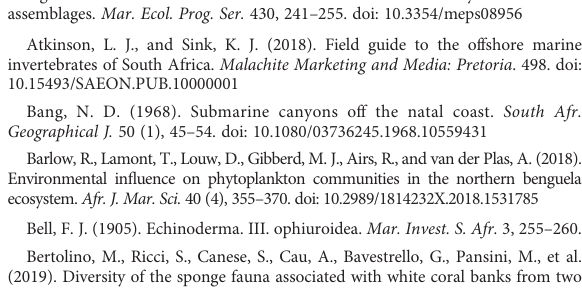
SUPPLEMENTARY FIGURE :2 Comparison between the (A, C). Gridded split-beam bathymetric data collected for this study and (B, D). de Wet (2013) gridded regional bathymetry. (A) Gridded using the Kriging statistical method, with a node spacing of 0.33 decimal degrees. (C) Frame A. close-up of the Cape Canyon and surrounding shelf areas. (B) de Wet (2013) bathymetry clipped to the same blanking fi le used on the Cape Canyon dataset. (D) Frame (B) . close-up of the Cape Canyon and surrounding shelf